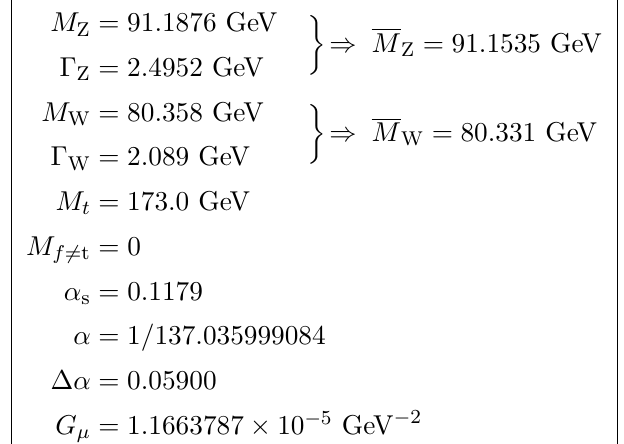
Table 1 . Benchmark values for the input parameters used in the numerical analysis, based on refs. [65,